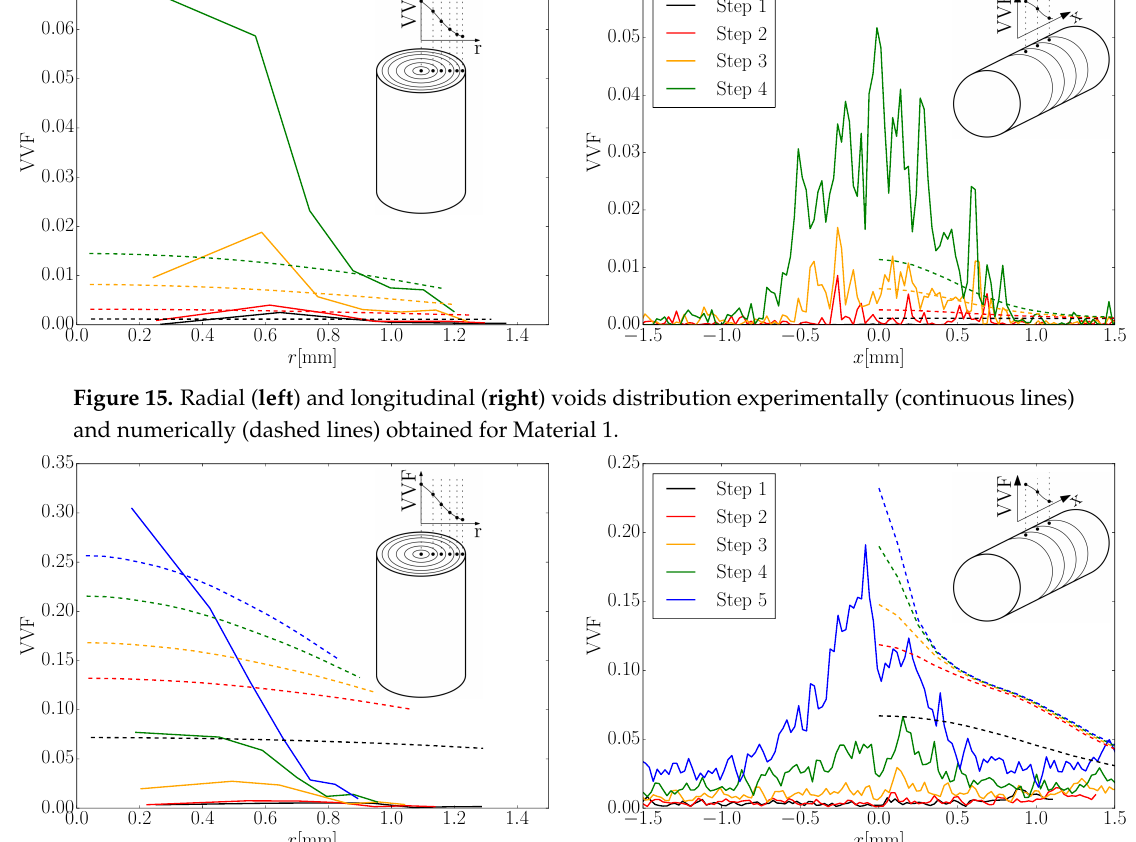
Figure 16. Radial ( left ) and longitudinal ( right ) voids distribution experimentally (continuous lines) and numerically (dashed lines) obtained for Material